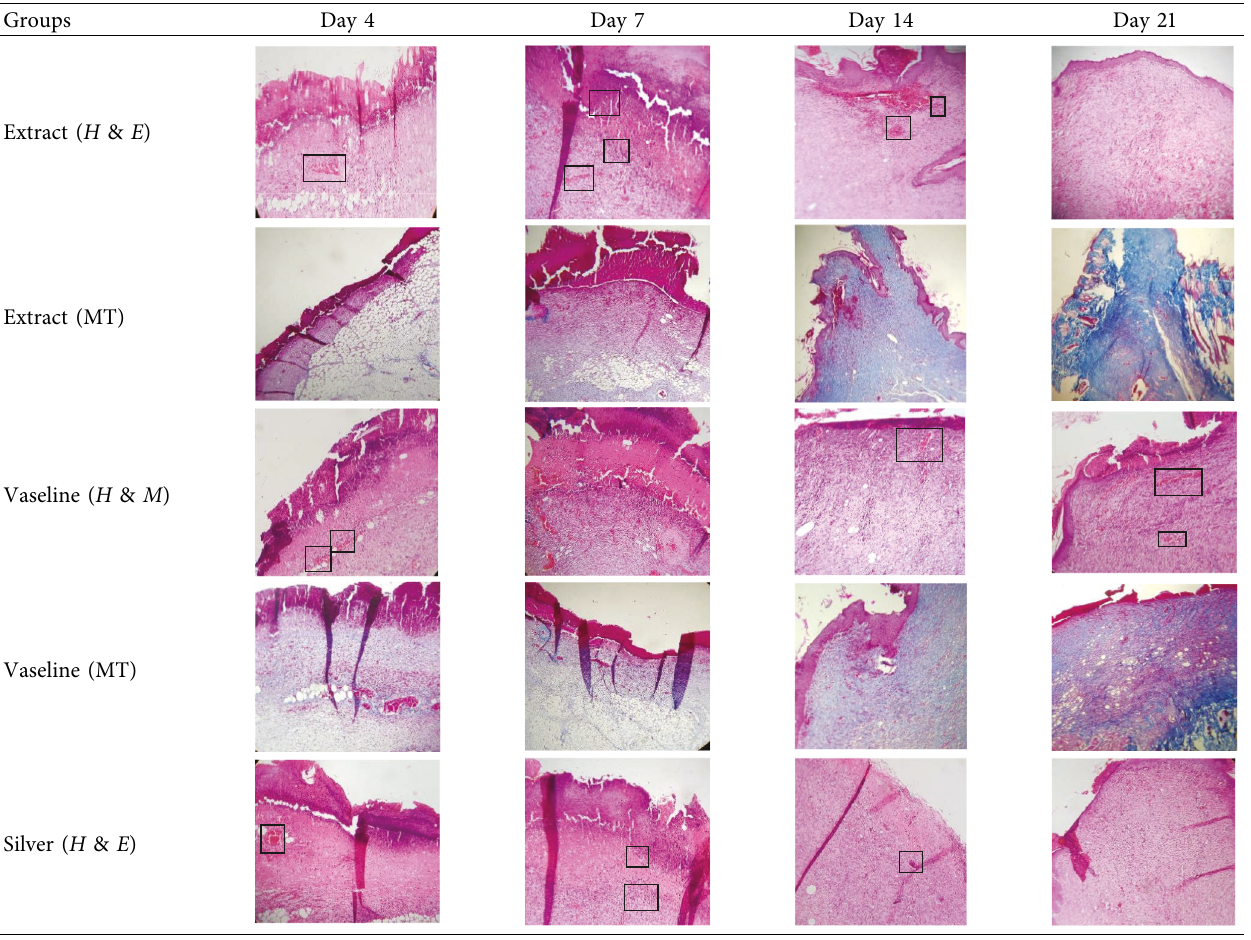
Table 7: Microscopic images (40 × ) of different treatment groups’ tissue samples after being stained with hematoxylin and eosin ( H & E )